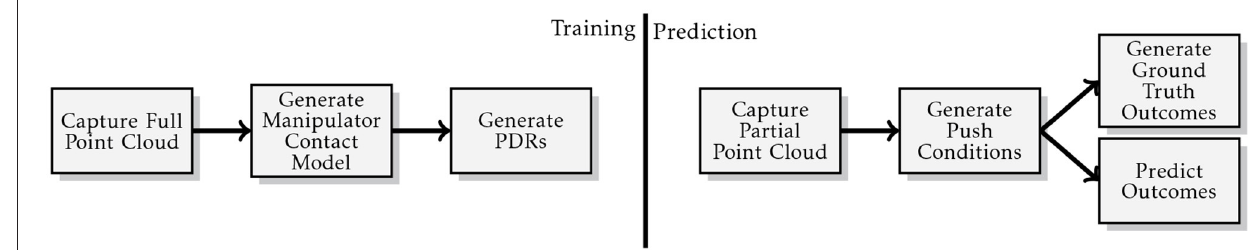
FIGURE 6 | Illustration of the generalised “Model Prediction Accuracy” experiment methodology.